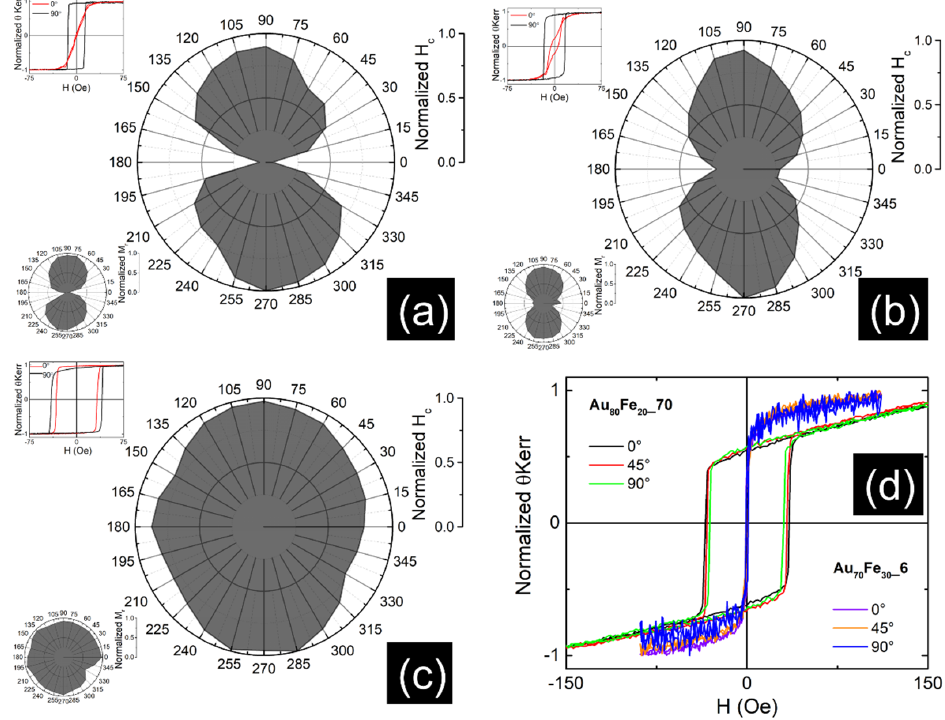
Figure 5. Polar graphical representation of normalized Hc obtained from MOKE hysteresis curves acquired at different azimuthal angles (inset shows the normalized M r in function of recording azimuthal angles and the hysteresis loops corresponding at 0° and 90°) for sample ( a ) Au 70 Fe 30 _70, ( b ) Au 70 Fe 30 _17 and ( c ) Au 20 Fe 80 _70; the hysteresis loops from ( d ) were obtained on sample Au 80 Fe 20 _70 and Au 70 Fe 30 _6.